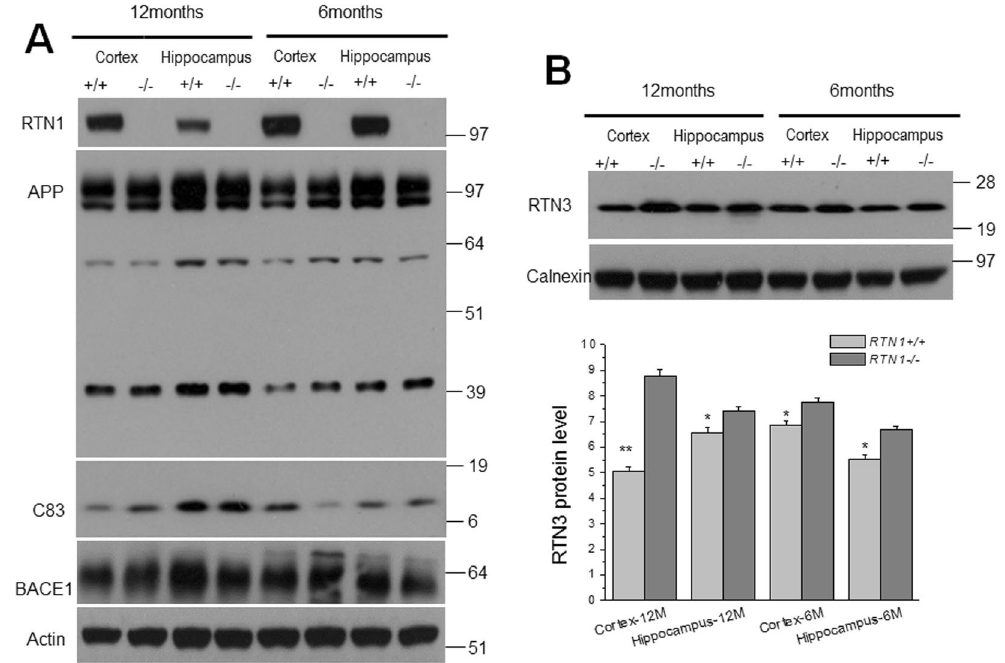
Figure 4. RTN1 deficiency increases RTN3 expression in brains. ( A ) Hippocampal protein lysates were prepared from 6- and 12-month-old WT and RTN1-null mice. Western blots were examined by antibody R418 to detect RTN1 expression and by A8717 to detect APP and its C-terminal fragments. No significant changes in APP-C83 levels were detected following RTN3 deletion. ( B ) A clear elevation of RTN3, as detected by R458, was observation on the western blot. Loading control was an antibody to calnexin. ( C ) Bar graphs showed relative levels of RTN3 over the loading control. (N = 4 independent experiments, * P < 0.05, ** P < 0.01, Student’s t